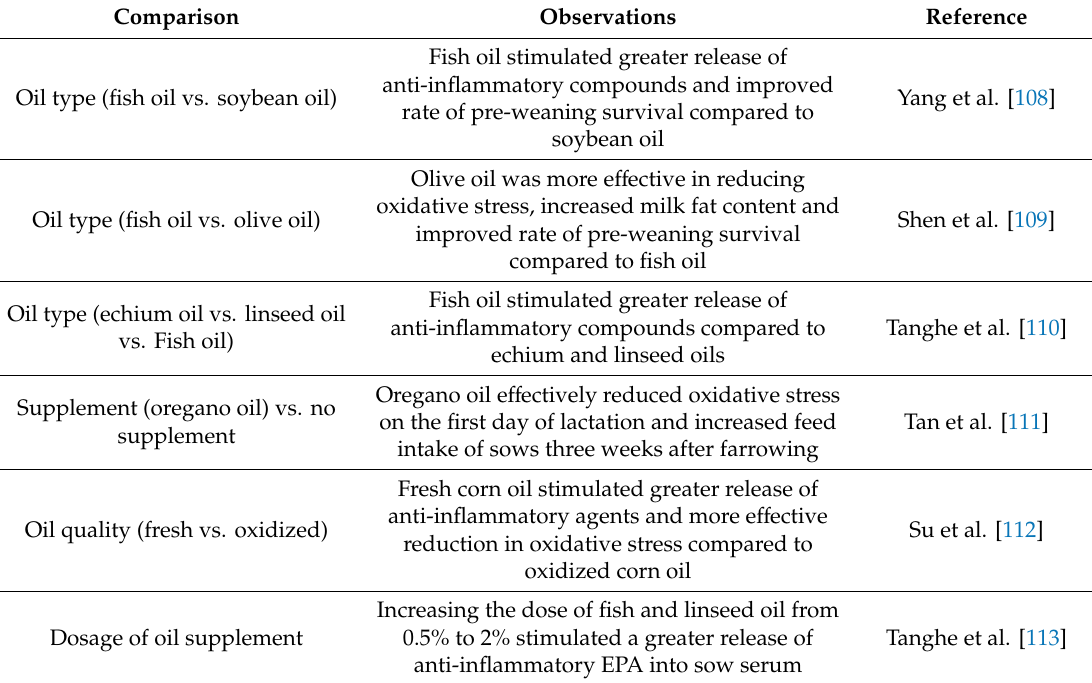
Table 2. Factors influencing the e ff ectiveness of oil